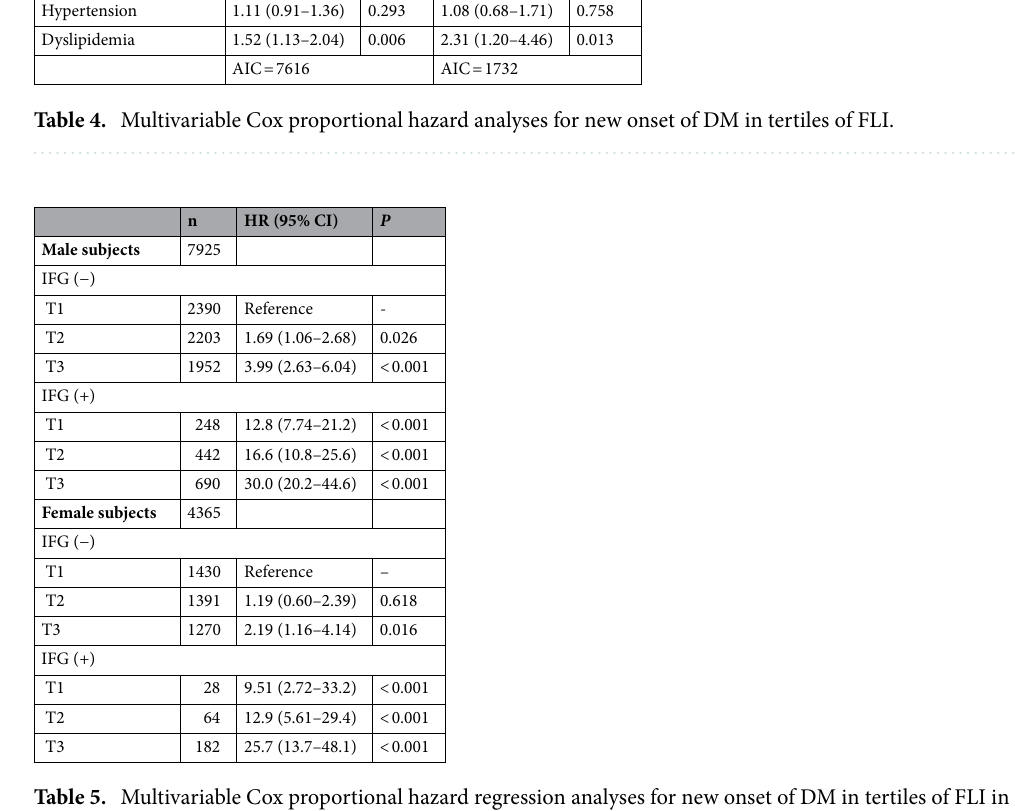
Table 5. Multivariable Cox proportional hazard regression analyses for new onset of DM in tertiles of FLI in the absence and presence of IFG. CI confidence interval, DM diabetes mellitus, FLI fatty liver index, HR hazard ratio, IFG impaired fasting glucose. IFG was defined as fasting plasma glucose ≥ 100 mg/dL. The model was adjusted for age, smoking habit, alcohol drinking habit, family history of DM, hypertension and